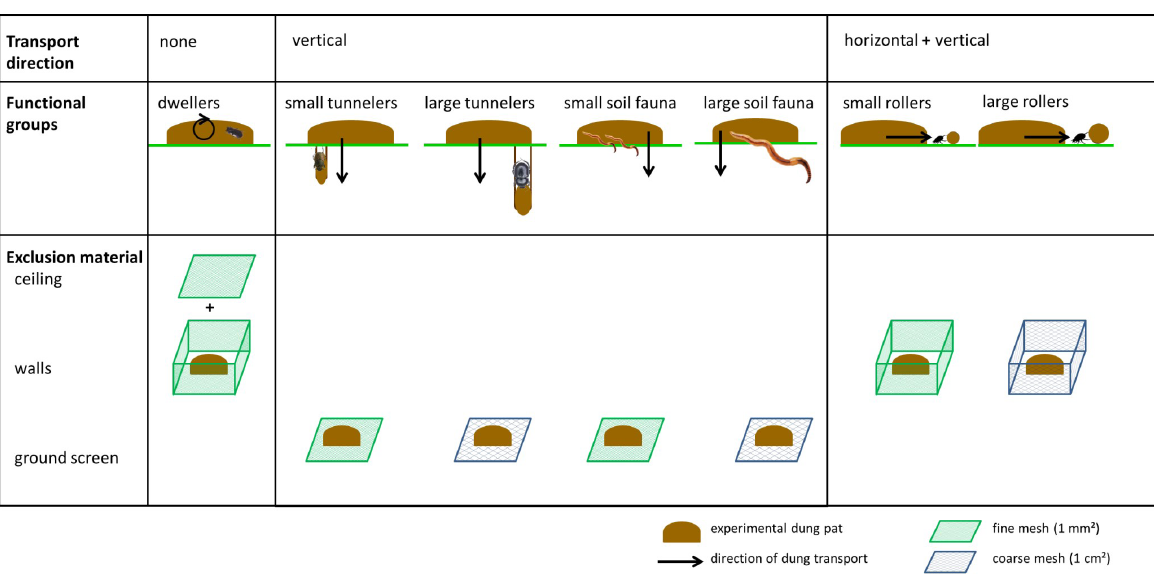
Figure 2. Functional groups defined in the experiments, the direction of dung transport for each group, and the type of material used to prevent dung removal by each functional